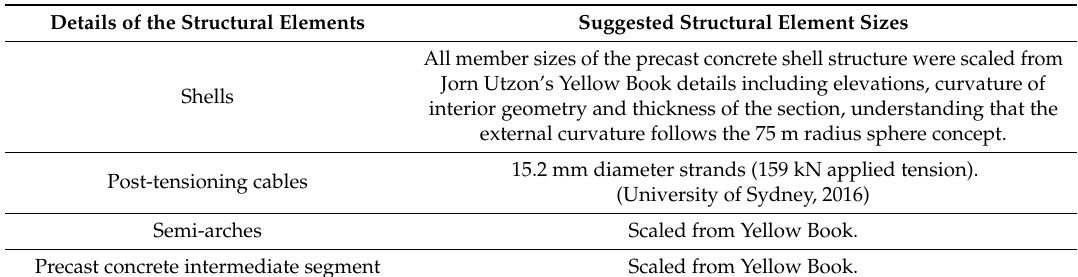
Table 2. Structural elements of the Sydney Opera House.